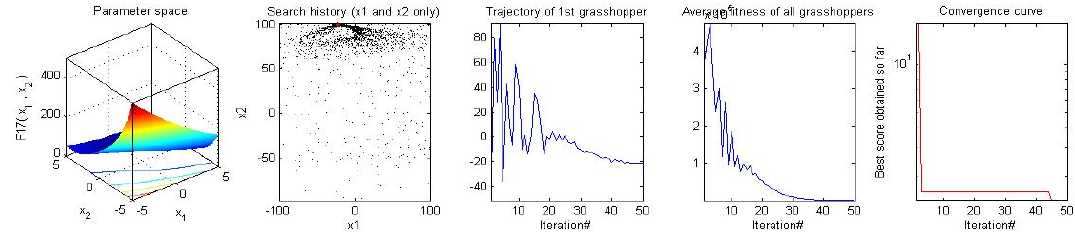
Figure 18. HAGOA behavior on multimodal function